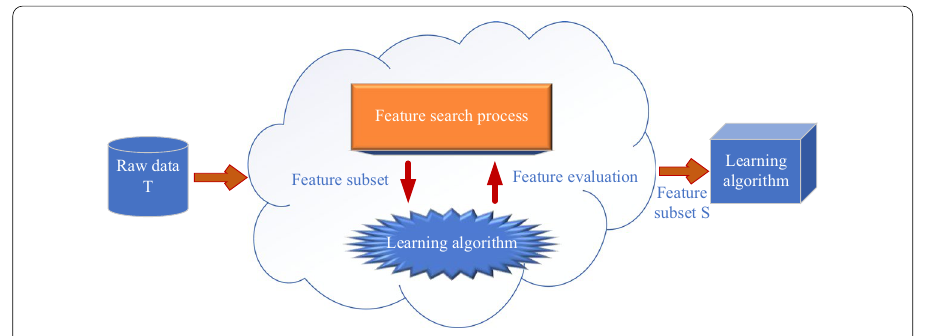
Fig. 5 Process of filtering selection of features